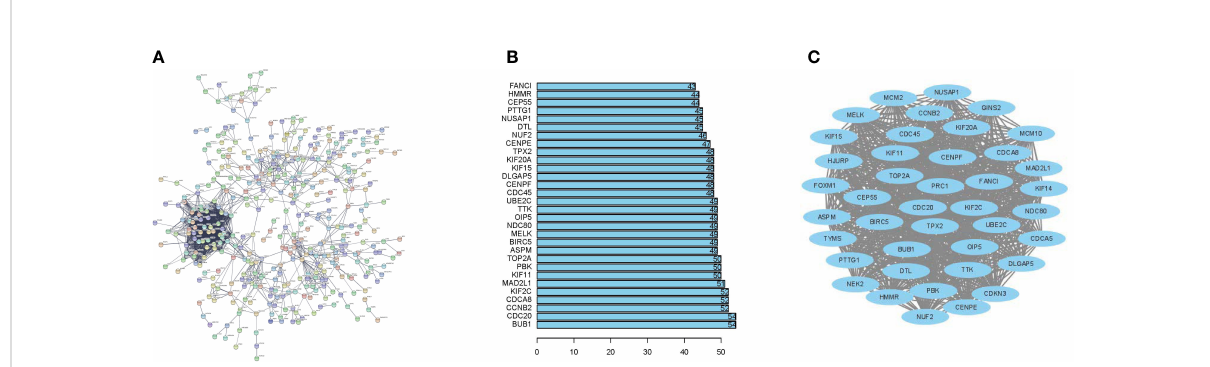
FIGURE 3 Protein-protein interaction (PPI) network, hub gene screening, and hub cluster. (A) PPI network (688 DEGs fi ltered into the PPI network that contained 685 nodes and 1703 edges). (B) The predicted association rank (from low to high) of the top 30 genes in the PPI network. (C) The key